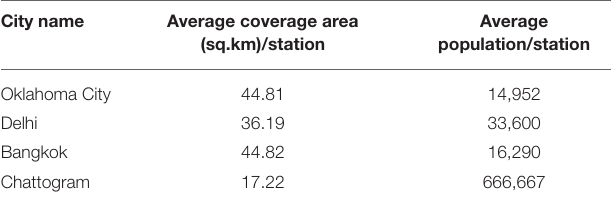
TABLE 2 | Coverage area and serving population per station of different